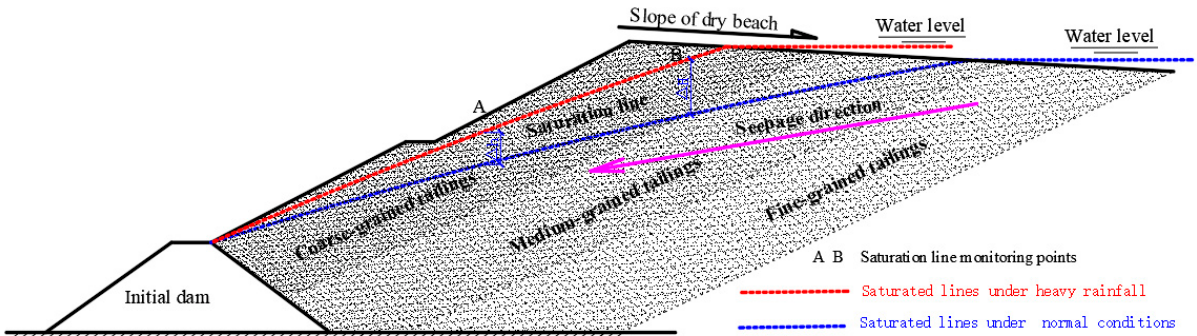
Figure 1. Sedimentary and seepage characteristics of upstream tailings dam.